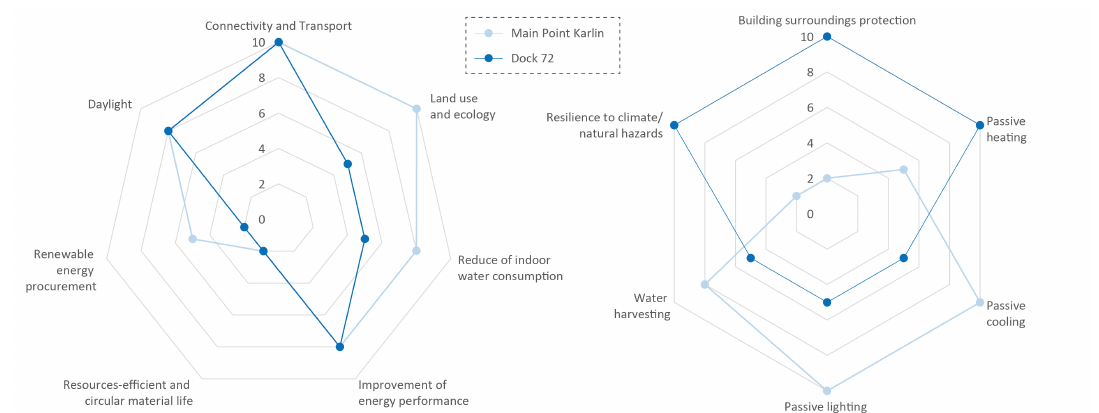
Figure 2. Analysis of the two case studies for sustainability (left) and resilience (right) according to the defined